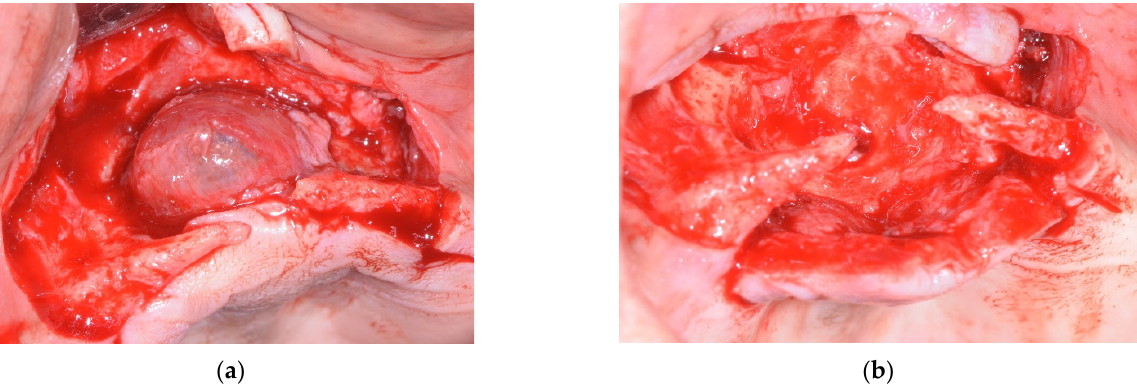
Figure 3. Intraoperative view ( a ) before and ( b ) after the cystectomy. Histopathological examination revealed a fibrous wall lined in part by a thin stratified non-keratinized squamous epithelium and in part by a cuboidal or respiratory-type ep- ithelium with ciliated cells containing a scanty lymphoplasmocytic inflammatory infiltrate. These features allowed for a diagnosis of an NPDC (Figure